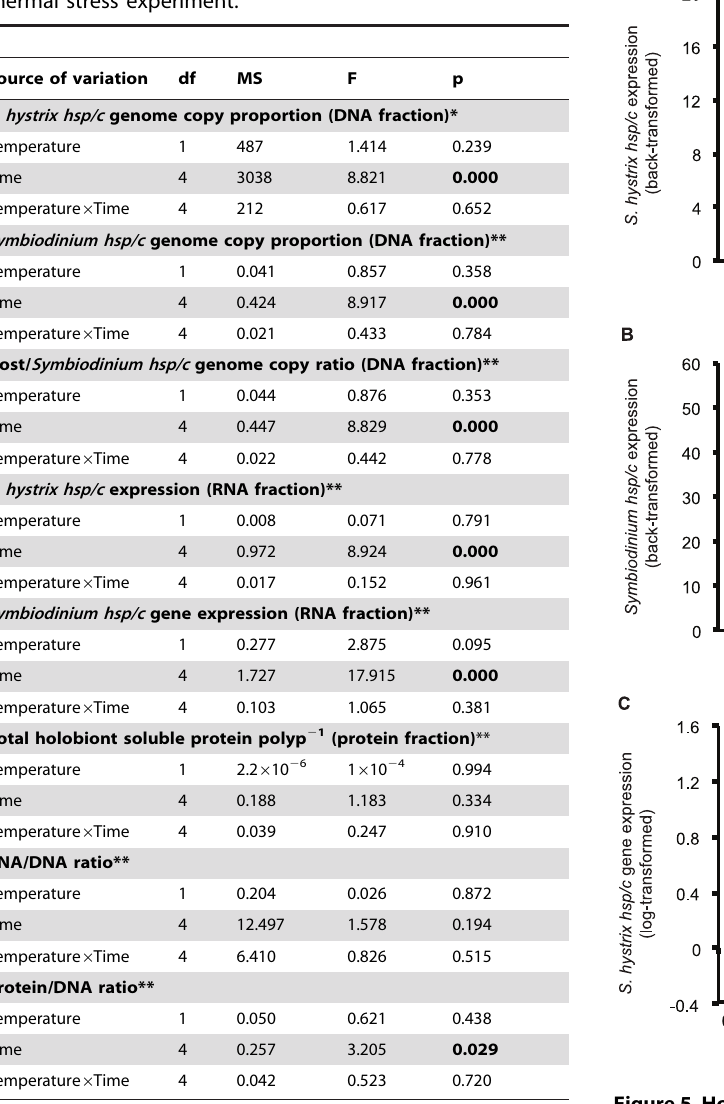
Table 2. 2-way ANOVA table for molecular data from the thermal stress experiment.